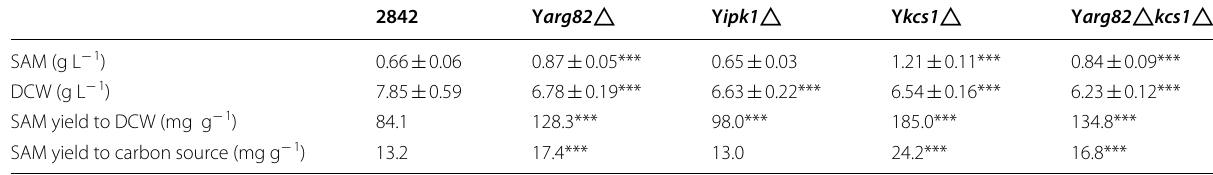
The symbol *** denotes significant diferences between the recombinant strain and the wild strain, with p <